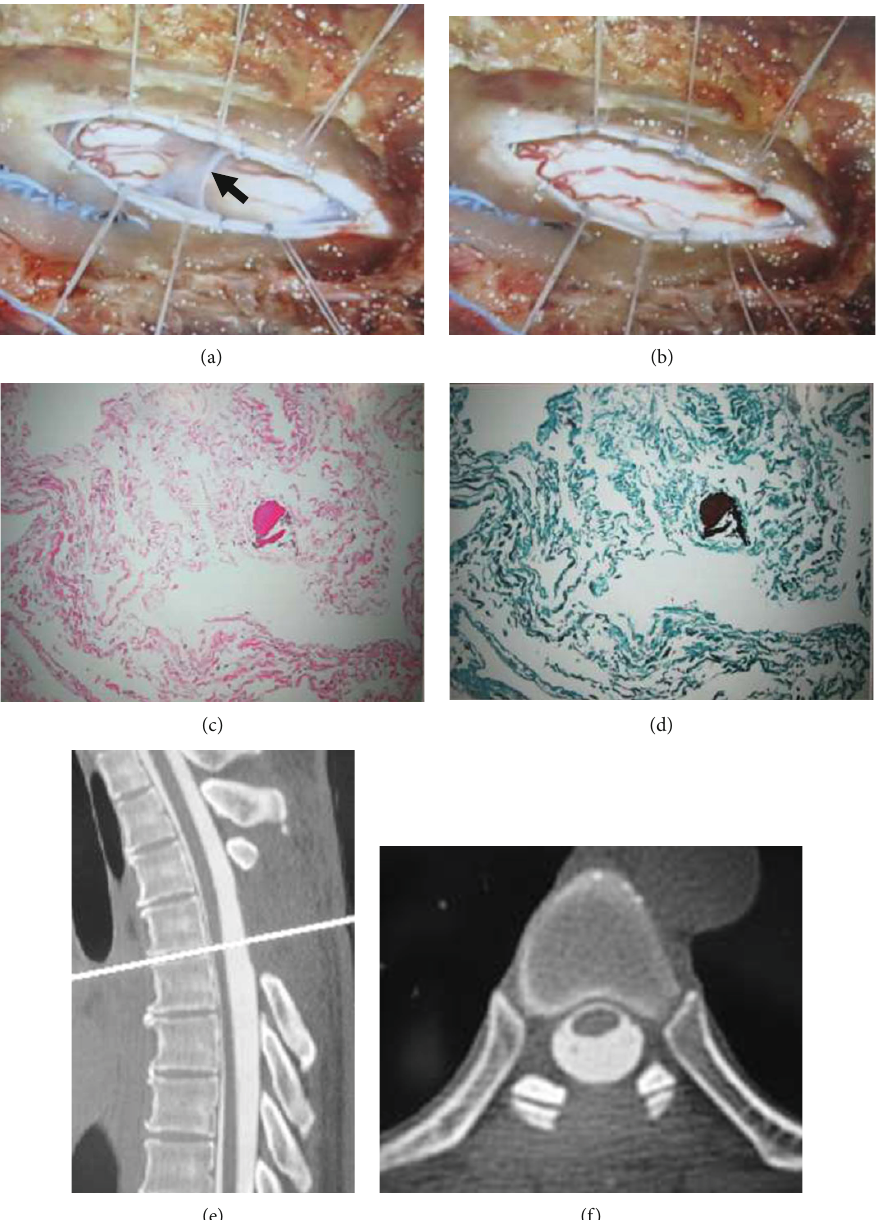
Figure 4: (a) The right side is cranial, and the left side is caudal. The dura and arachnoid are incised. The arachnoid web is still present as a restiform structure (black arrow). (b) After resection of the arachnoid web. (c) Hematoxylin and eosin staining shows fi brous tissue and microcalci fi cations. (d) Elastica-Masson staining shows epithelial tissue. (e, f) Postoperative sagittal and axial CT myelography show no spinal cord deviation, and the “ scalpel sign ” has vanished. The white line shows the T5/T6 disc